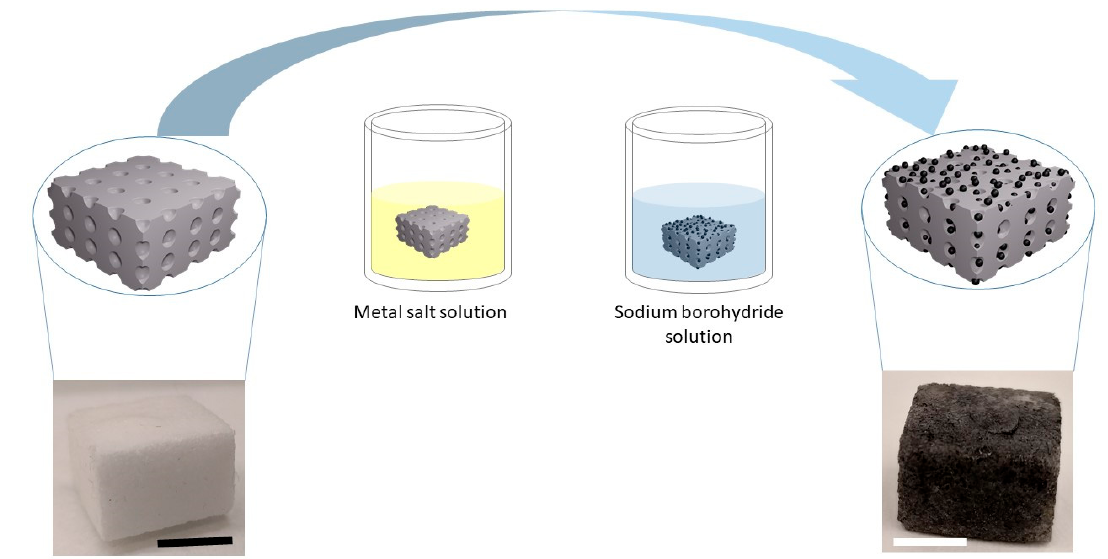
Scheme 1. Schematic representation of the synthesis process for the catalysts based on PDMS sponges supported metal nanoparticles. Scale bars represent 1 cm.